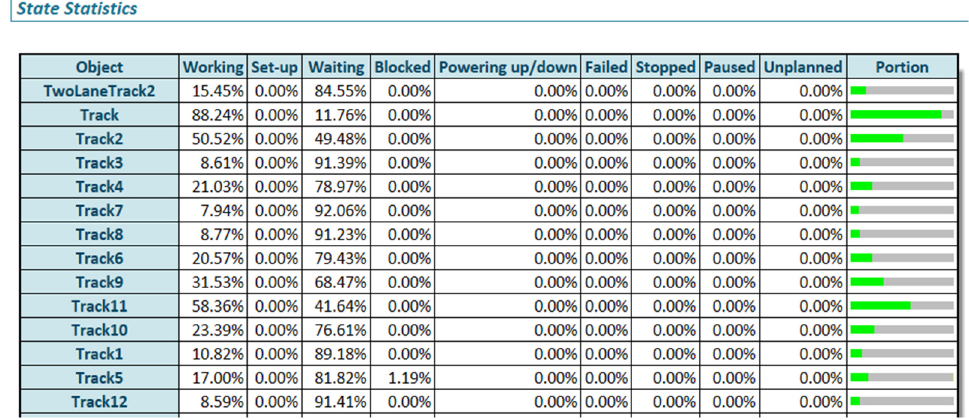
Figure 19. Presentation of a part of simulation experiment results in PTV Vissim.